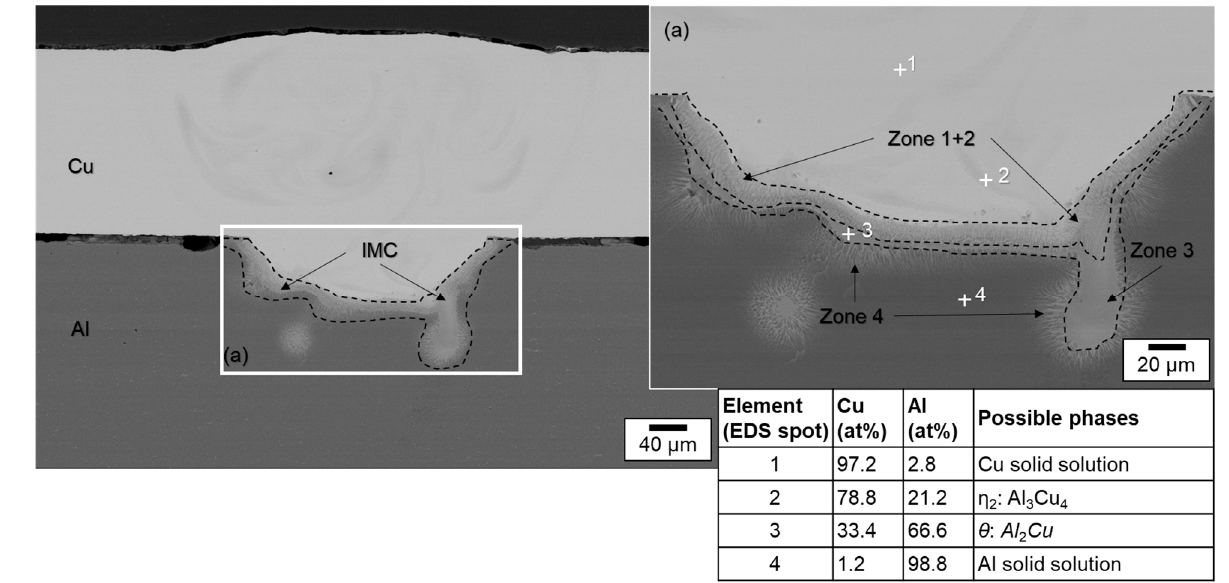
Figure 14. SEM image and EDS scanning spots in the weld seam of the sample produced with parameter set #2; white insert (a) indicates the area of the displayed detail image (a); dashed line indicates intermetallic phases ( top ); EDS phase composition at selected scanning spots ( right bottom ).